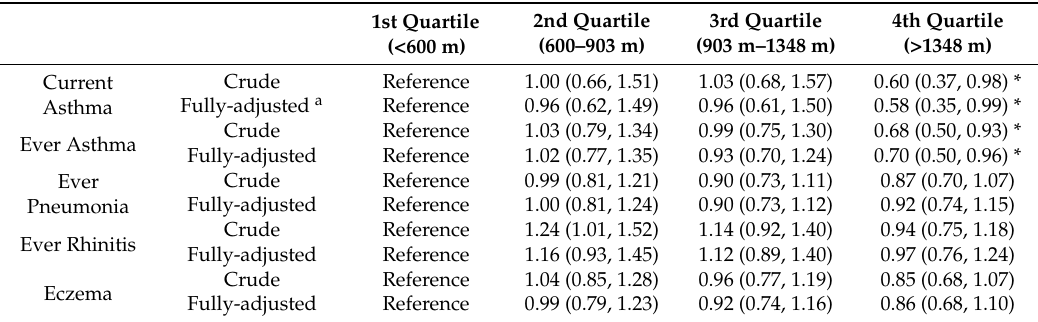
Table 4. Crude and fully-adjusted odds ratios (ORs) (95% CIs) of targeted outcomes associated with quartiles of distance from a